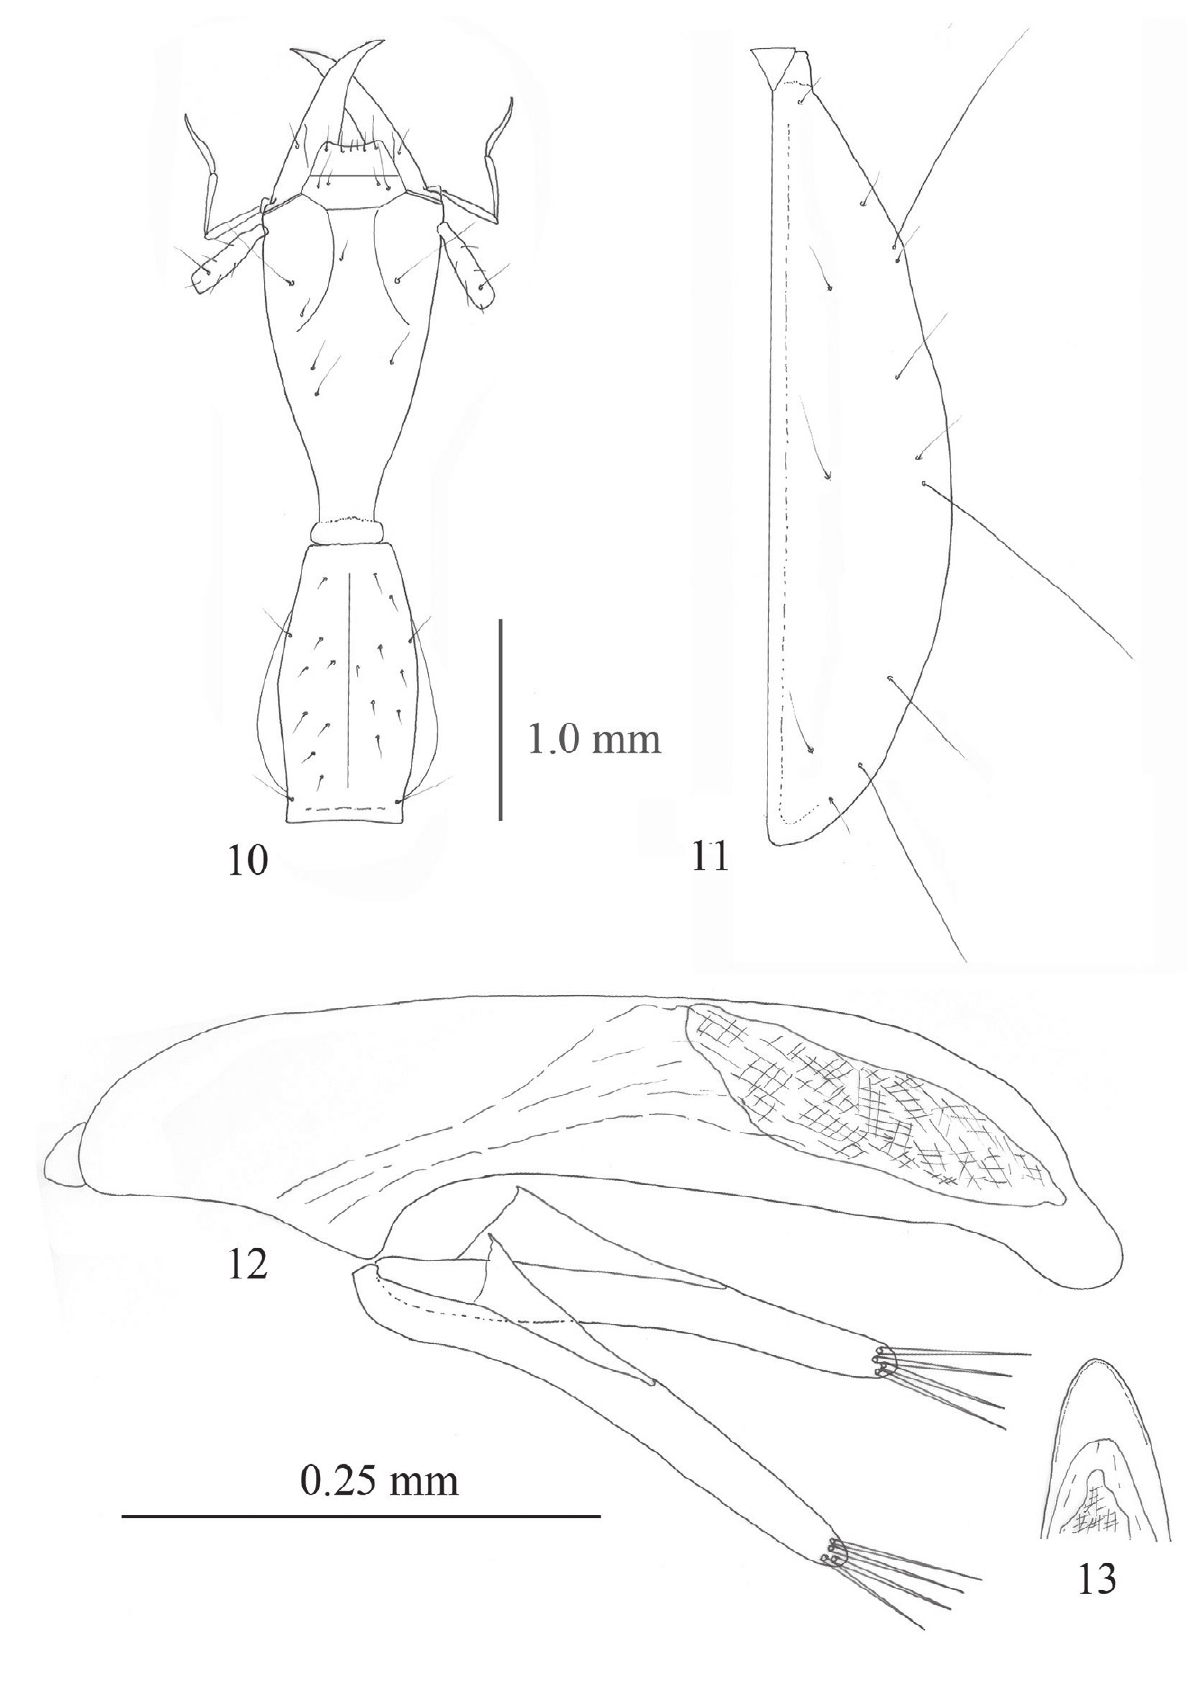
Figs 10-13 - Dongodytes baxian , sp. nov., holotype (10, head and prothorax; 11, right elytron; 12, aedeagus, lateral view; 13, apical part of aedeagus, dorsal